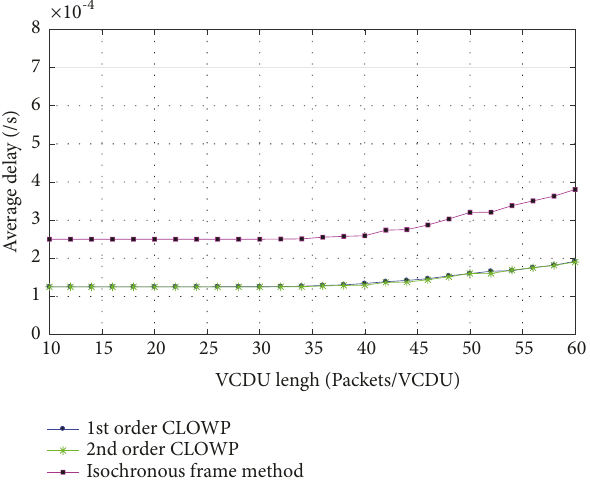
Figure 6: Comparison of average delay between CLOPW and isochronous frame